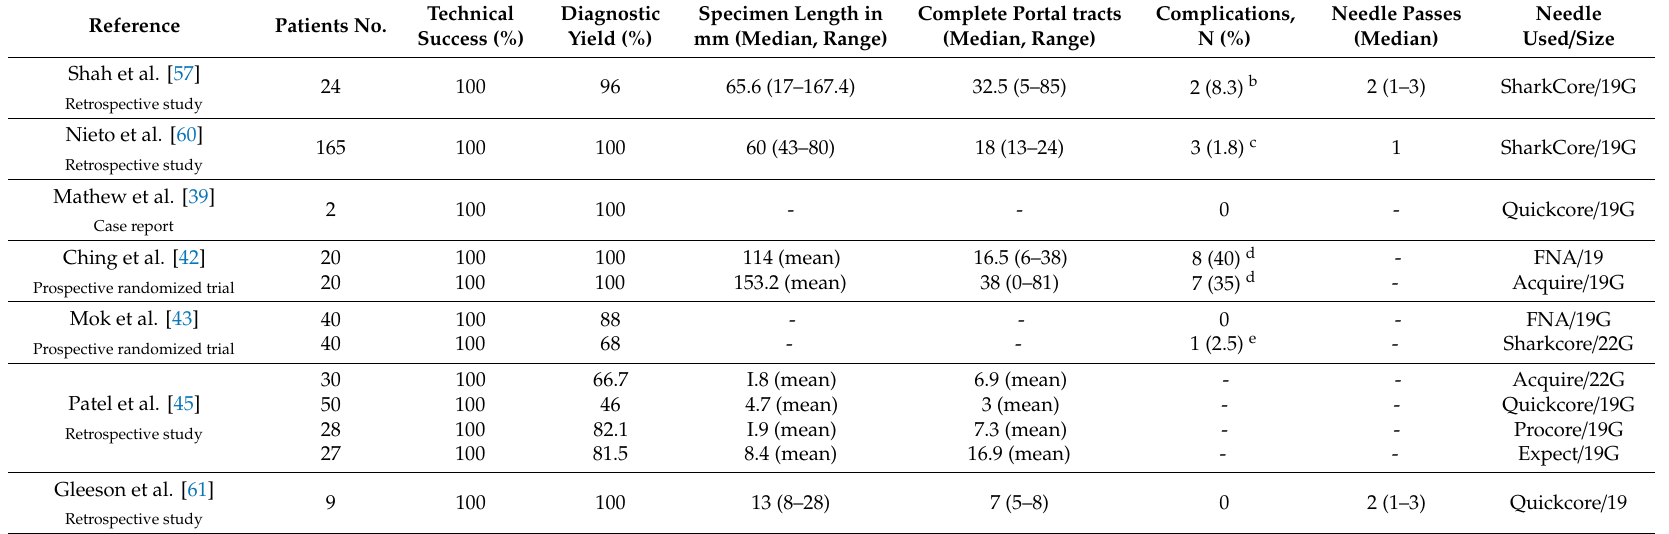
Table 3. Studies reporting the e ffi cacy and safety of EUS-FNB-guided liver biopsy in patients with chronic liver